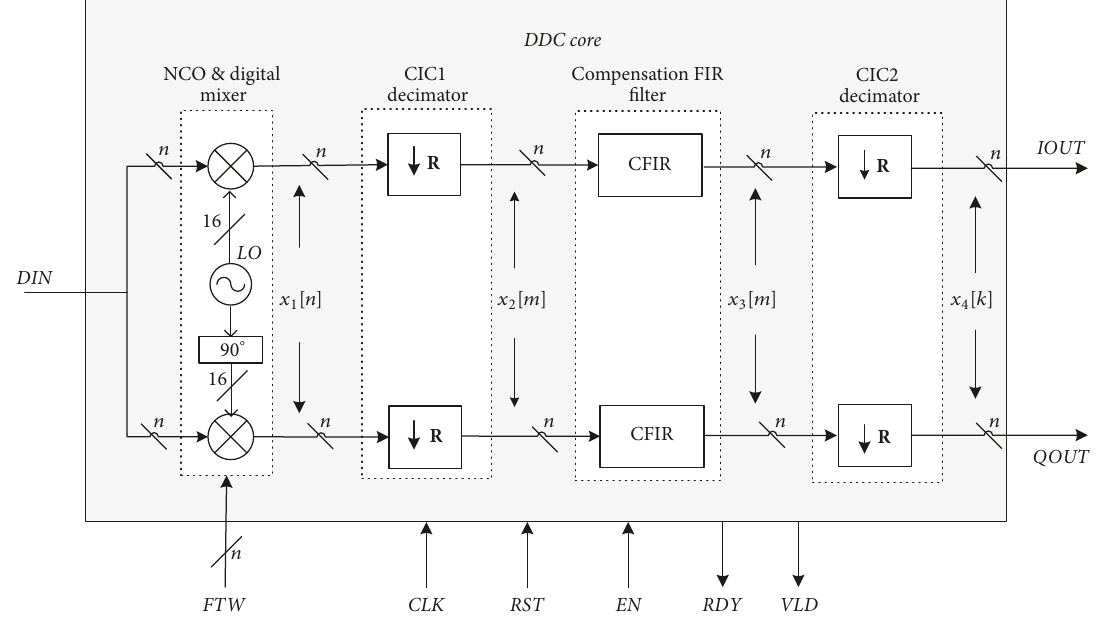
Figure 9: A structure of the Digital Down Converter.